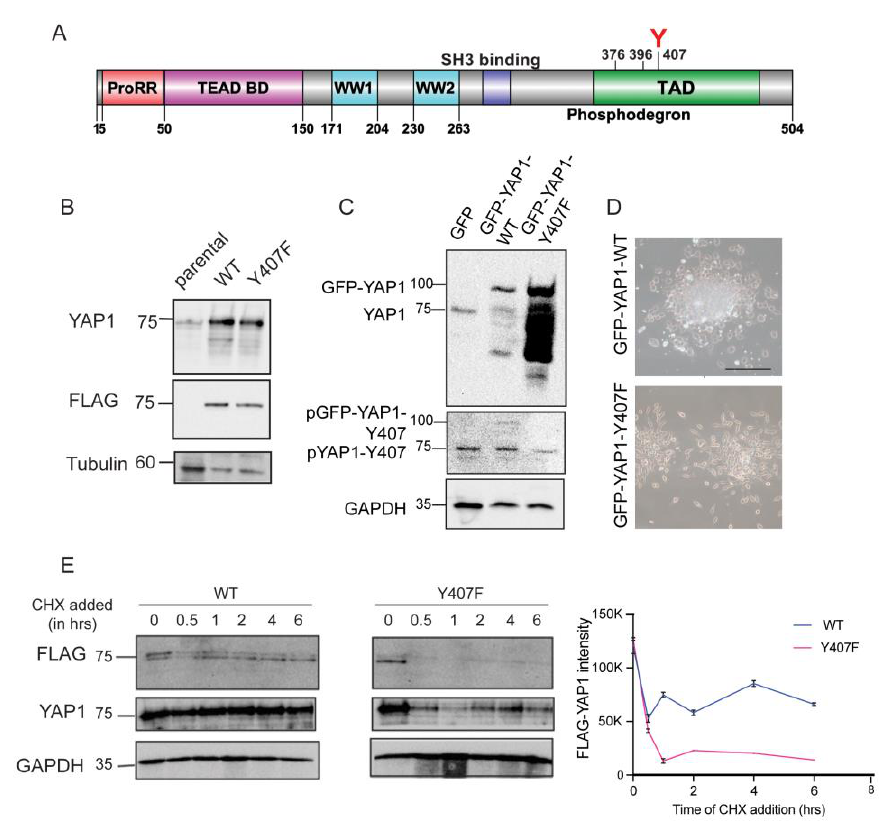
Figure 1. Expression of YAP1-WT and Y407F mutant in Hek293 and LNCaP cells. ( A ) YAP1 do- main map showing full-length human YAP1 (504 aa) with different regions. Proline-rich region (ProRR), TEAD binding domain (TEAD BD), WW domains (WW1 and WW2), SH3 binding region, phosphodegron motif (376–396 aa) within the transcription activation domain (TAD) in proximity to Y407. ( B ) Immunoblot showing the expression of the FLAG-tagged YAP1-WT and Y407F mutant, and endogenous YAP (parental) in Hek293 cells examined with pan-YAP or FLAG antiserum. ( C ) Expression of GFP-YAP1-WT and Y407F mutant in LNCaP cells was probed with the anti-YAP1, anti-GFP, and anti pYAP1-Y407 antibody. ( D ) Specific morphology alteration of LNCaP cells express- ing GFP-YAP1-WT. Note the rounded appearance and overlapping growth pattern, which was not seen with the Y407F mutant-expressing cells that retained “normal” LNCaP morphology. Scale bar is 100 µ m. ( E ) Cycloheximide chase assay (CHX) performed at indicated timepoints to determine the stability of the YAP1-WT and YAP1-Y407F protein in Hek293 cells. Immunoblots probed with indicated antibodies. Quantification of FLAG-YAP1 levels from CHX chase is shown to right. Results from three independent experiments ± SEM plotted.